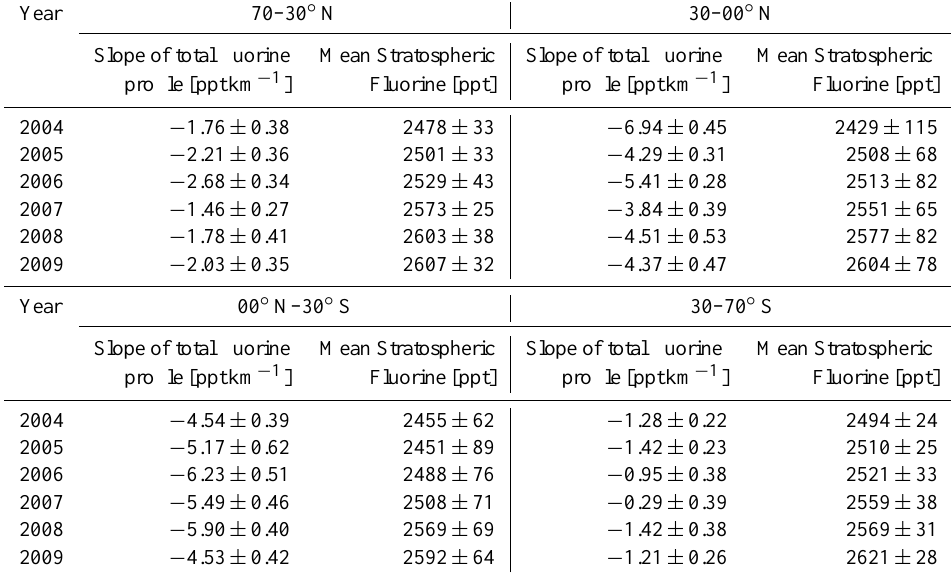
Table 4. The slopes of the total fluorine profile and the mean stratospheric volume mixing ratio of the fluorine budgets for different latitude bands. The error quoted here is the 1- σ error of the fit. Systematic errors in the ACE-FTS retrieval of these species are not known at this time and are not included in these